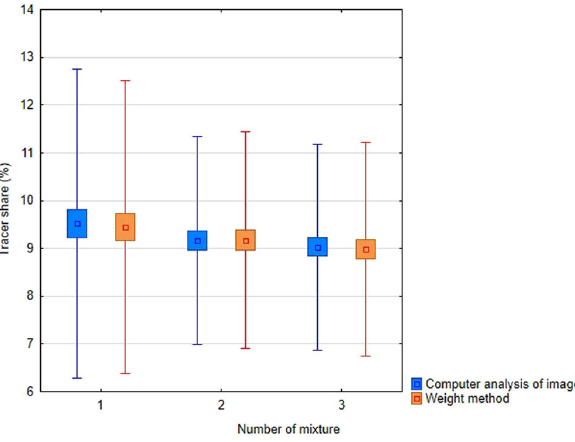
Figure 2: A box plot graph of the share of the tracer ( maize d = 2.00 mm ) obtained by two methods for the three mixtures analyzed ( point: mean, box: mean ± standard error, whiskers: mean ± 2 × standard deviation ) .